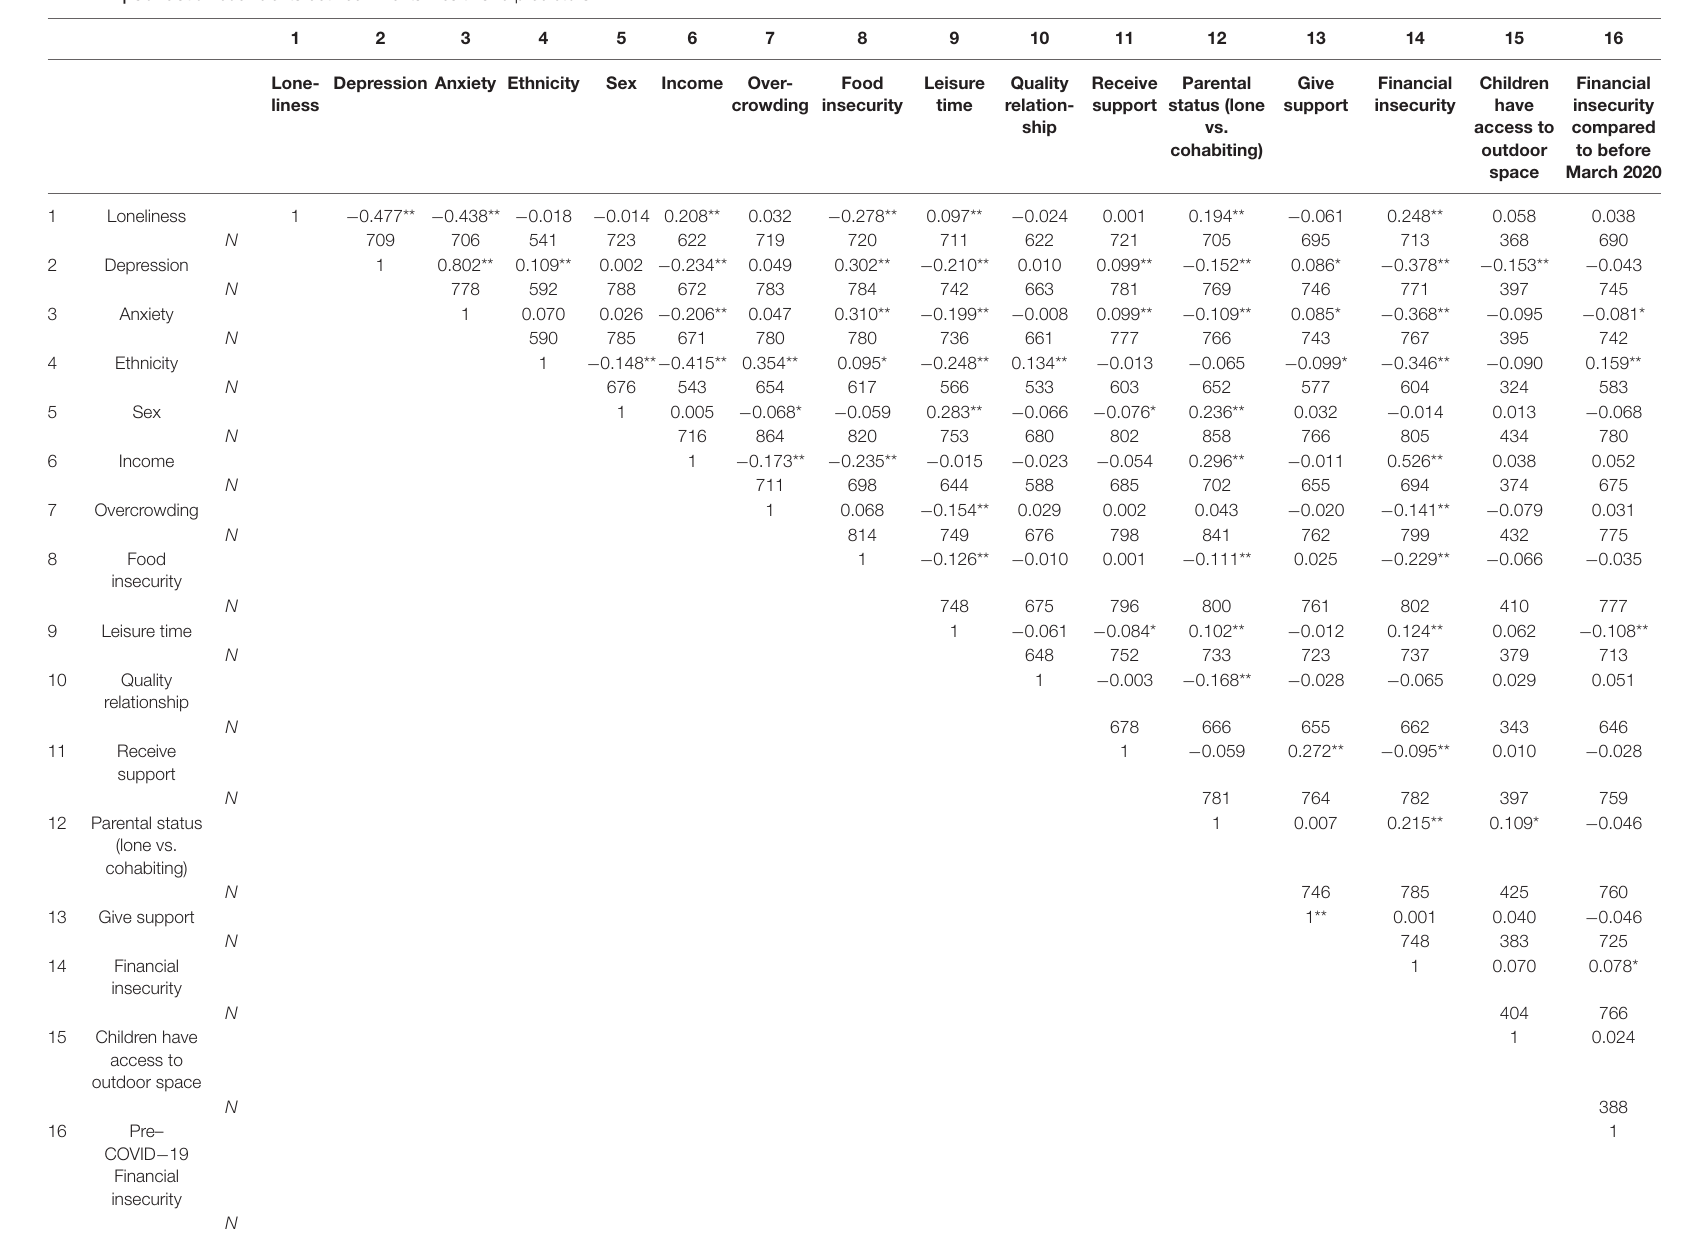
TABLE 2 | Correlation coefficients between mental health and